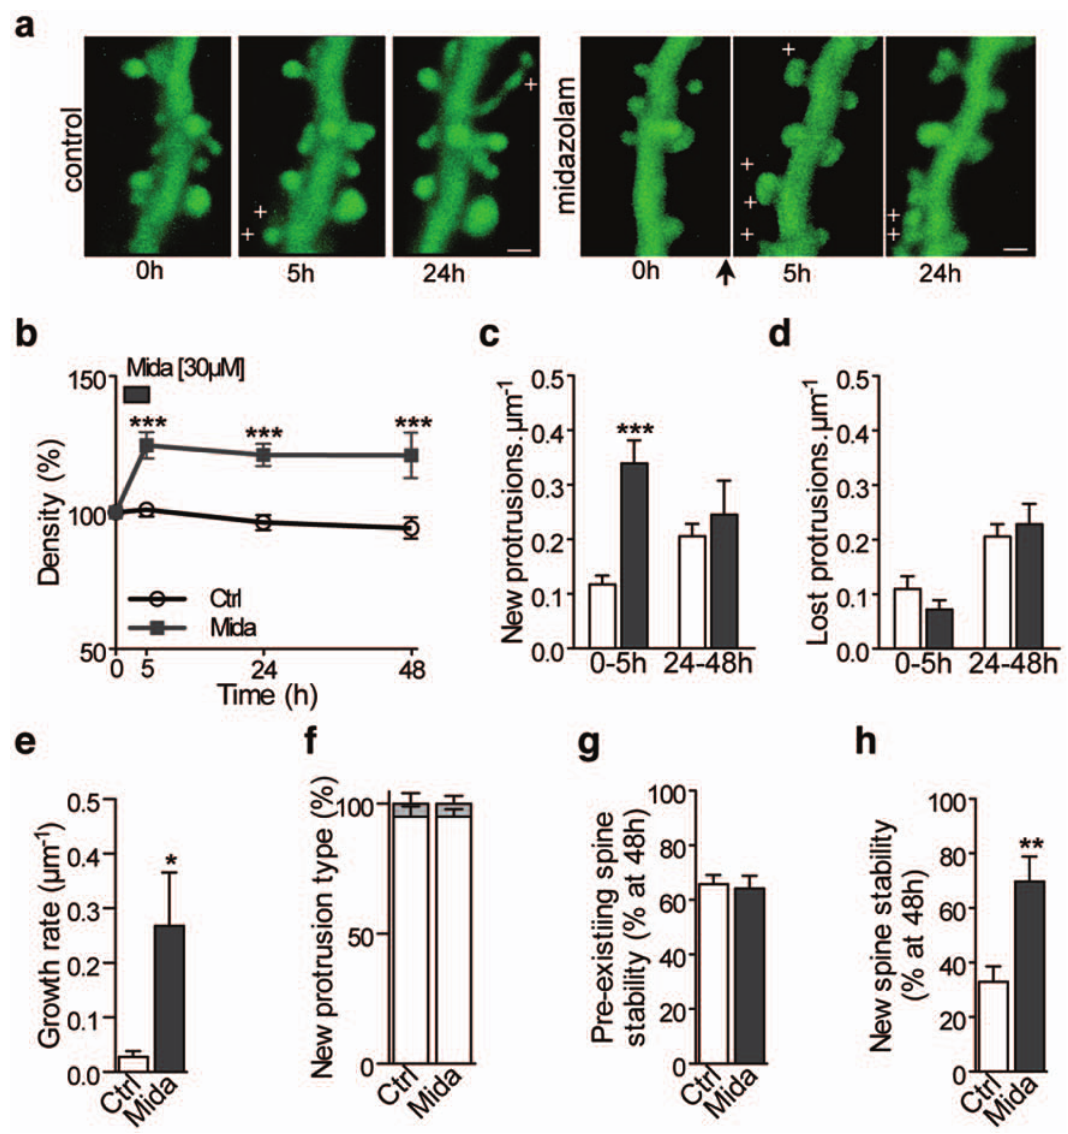
Figure 5. Spine dynamics underlying midazolam-induced increase in spine density. ( a ) Maximum intensity projections with 3D volume rendering of confocal images of a CA1 dendrite observed repetitively at 0 h; 5 h and 24 h showing the protrusion turnover in control conditions (left panel) and after midazolam (right panel). + : newly formed protrusions. Scale bar: 1 m m. Hippocampal slices were incubated with midazolam (30 m M) during 5 h just after the first observation (arrow). ( b ) Protrusion density (expressed as percent of initial values) observed at 0 h, 5 h, 24 h and 48 h in control condition (empty circle) and after midazolam treatment (dark squares). ( c ) New protrusions per m m detected between 0 to 5 h, or between 24 to 48 h in control conditions (white bars) and after midazolam treatment (dark bars). ( d ) Same as (c), but for lost protrusions. ( e ) Number of protrusions per m m that appeared after 1 hour midazolam incubation compared to control conditions. ( f ) Type of new protrusions for control (ctrl) and midazolam (mida). White bars: spines; gray bars: filopodia. ( g ) Fraction of spines present at the initial observation (pre-existing spines) still present at 48 h. ( h ) Fraction of new spines formed between 0 h and 5 h and still present at 48 h. Note that in (g) and (h), only spines were considered: filopodia were excluded because of their very short-term survival. (b–d; f–h): n =12; 13 cultures for control and midazolam conditions, respectively, 1726 protrusions analyzed. (e): n =4 cultures for each conditions, 293 protrusions analyzed. (b): 2-way ANOVA with Bonferroni post tests, (c–h): unpaired t